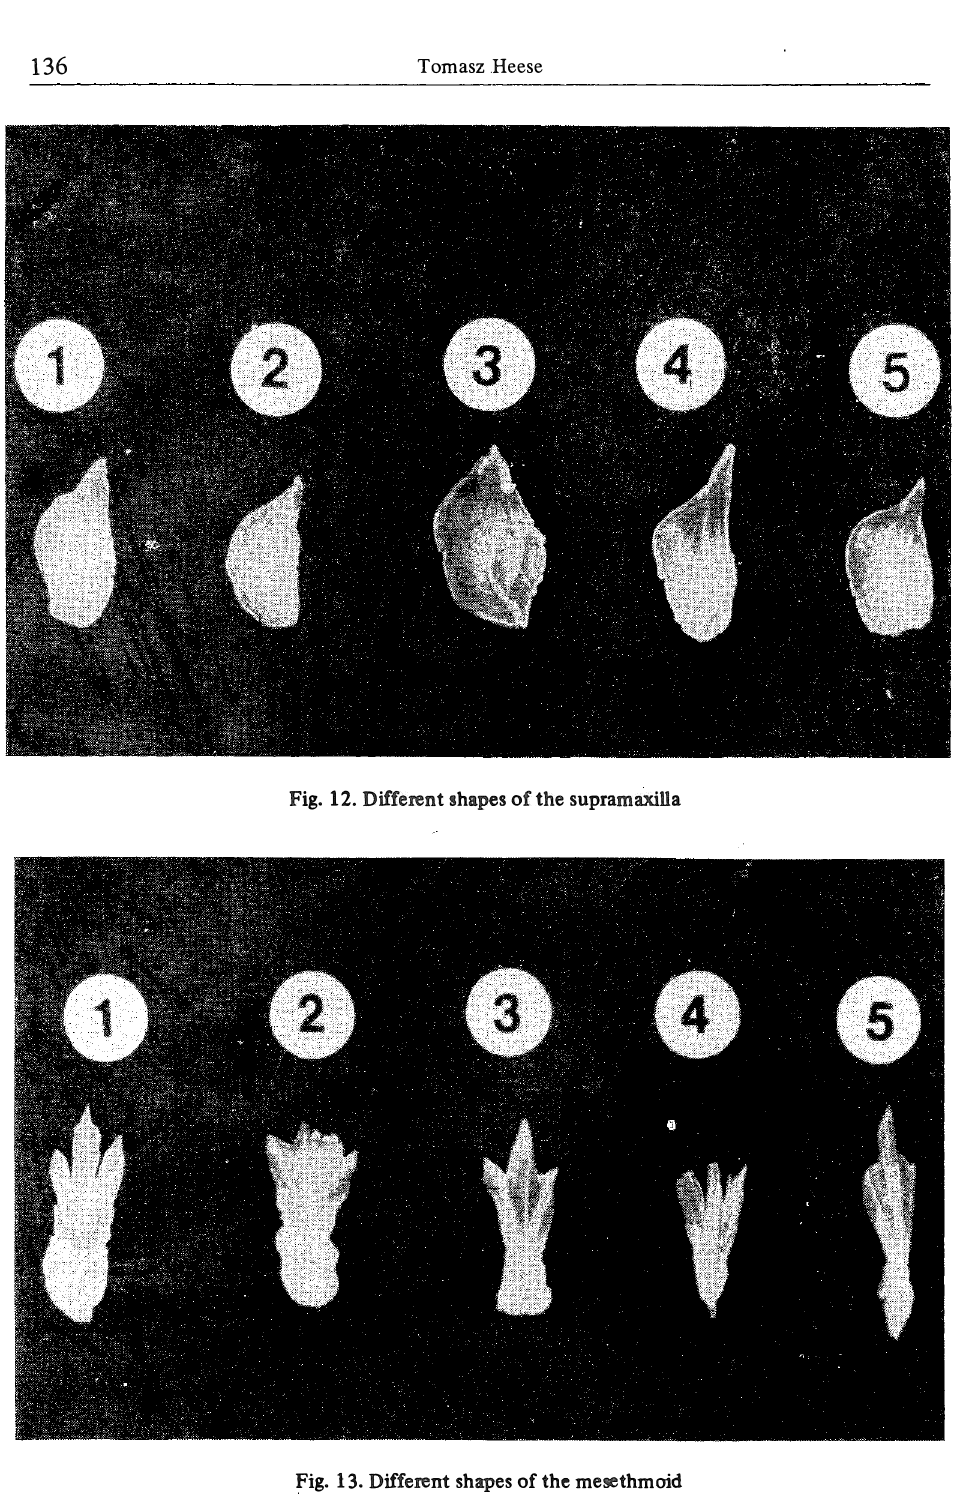
Fig. 13. Different shapes of the